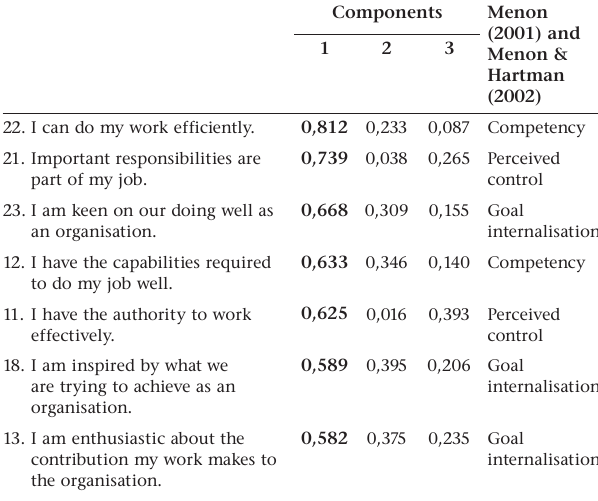
For this group the factors identified coincided with those identified in the three international studies. Just one item of the perceived control factor loaded on the competency factor as defined by